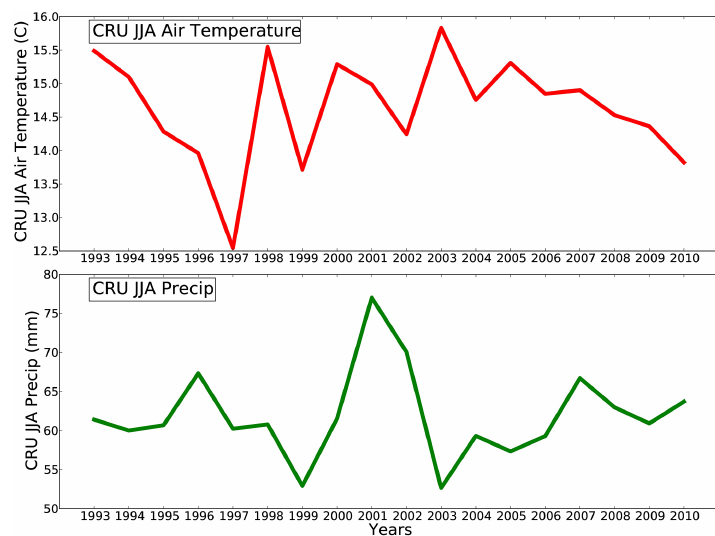
Figure 11. Time series of CRU JJA air temperature ( ◦ C) and precipitation